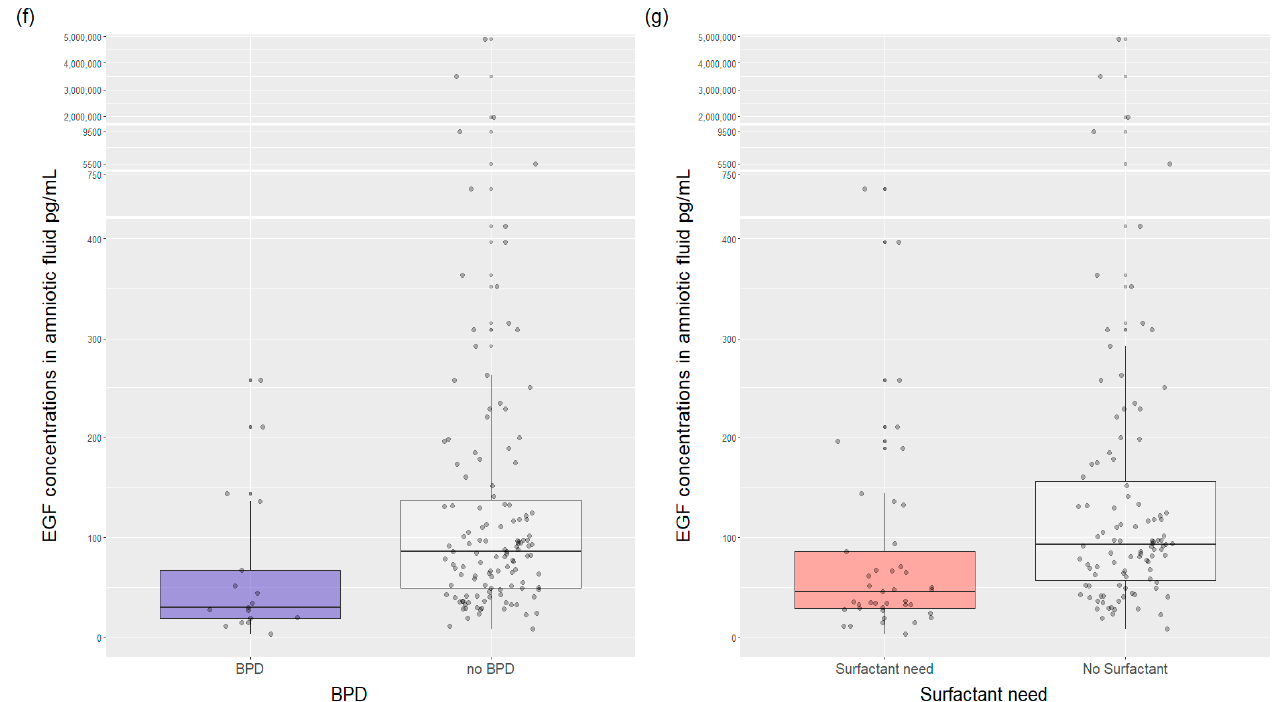
Figure 2. Median amniotic fluid EGF concentrations in neonates with respiratory outcomes compared with neonates without outcomes, ( p < 0.001 for all assays): ( a ) Median EGF concentrations with RDS vs. no RDS were 68.25 pg/mL vs. 124.29 pg/mL ( p < 0.001), respectively; ( b ) median EGF concentrations for severe RDS were 48.70 pg/mL vs. 63.80 pg/mL of moderate RDS vs. 88.20 pg/mL of mild RDS vs. 124.00 pg/mL of no RDS ( p < 0.001); ( c ) median EGF concentrations in infants with a need